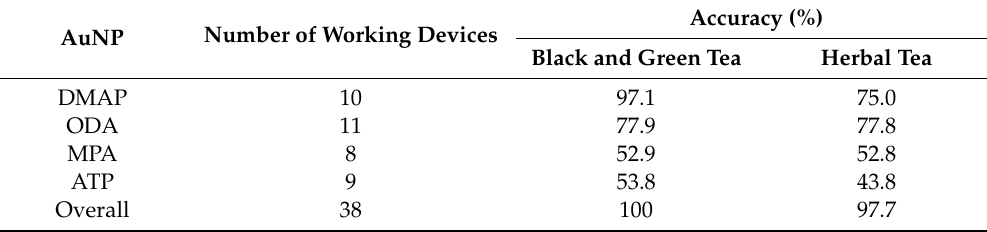
Table 2. Classification accuracy (LDA) comparison among di ff erent AuNP sensing elements.